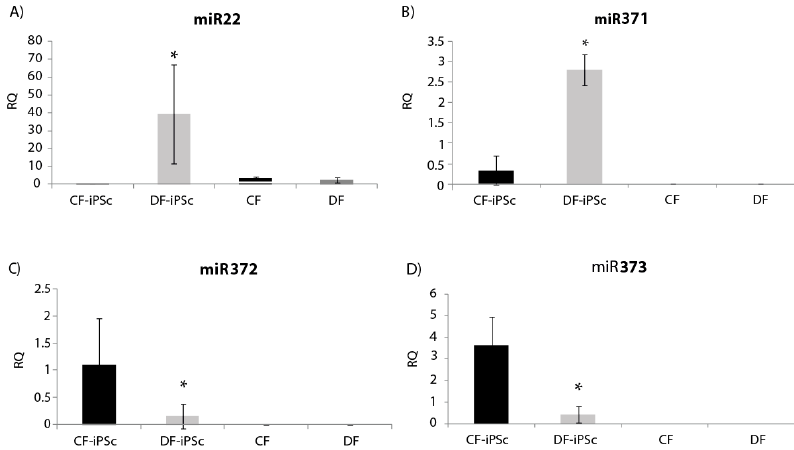
Figure 6. miR expression in iPSCs-derived exosomes. ( A ) miR22 expression in iPSCs exosomes, * p < 0.05. ( B ) miR371 expression, * p < 0.05. ( C ) miR372 expression, p < 0.05. ( D ) miR373 expression, p < 0.05. CF-iPSC ( n = 5), DF-iPSC ( n = 5), CF ( n = 4), DF ( n = 5).